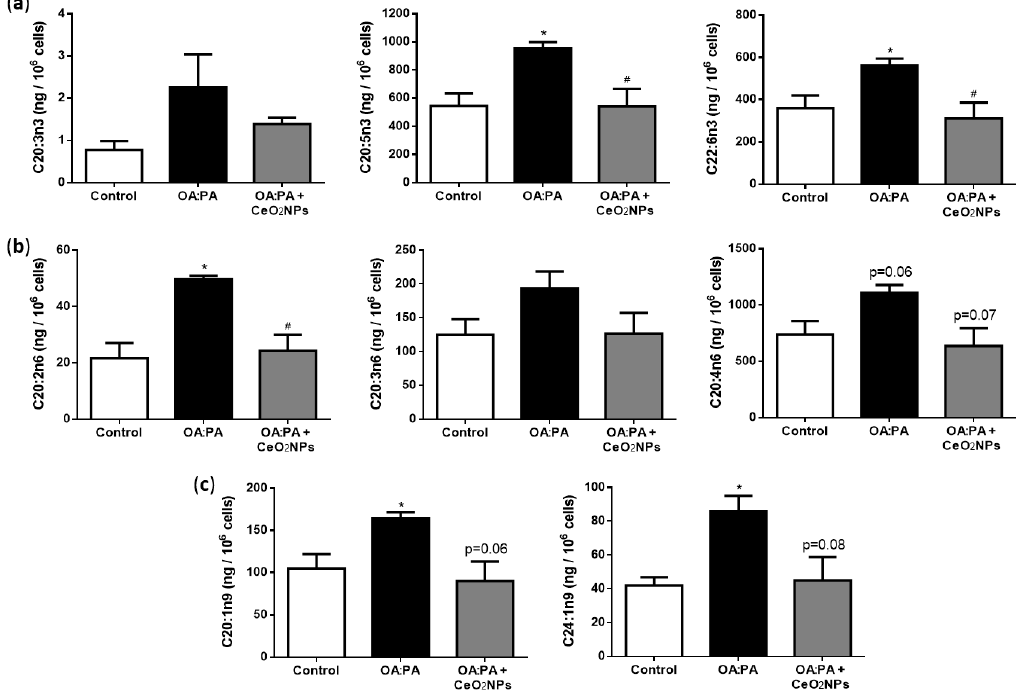
Figure 6. Cell content of n-3 ( a ), n-6 ( b ) and n-9 ( c ) unsaturated fatty acids larger than 18 carbons in control cells, cells incubated with OA:PA (1.33:0.67 mM) and cells incubated with OA:PA treated with CeO 2 NPs (10 µg/mL). * p < 0.05 compared with control; # p ≤ 0.05 compared with OA:PA.